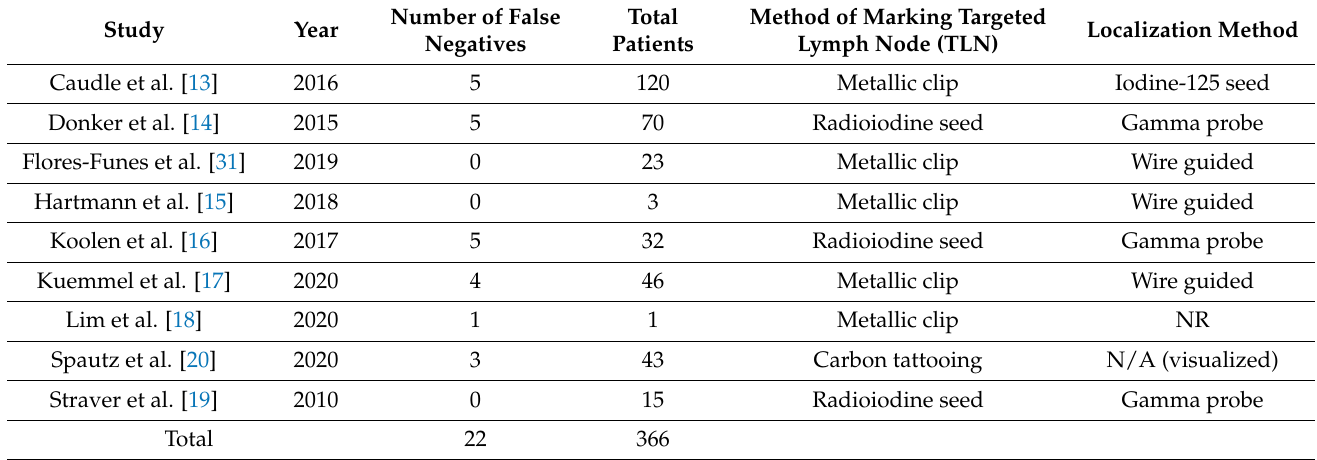
Table 1. Marked lymph node biopsy (MLNB) studies and false-negative rate (FNR).